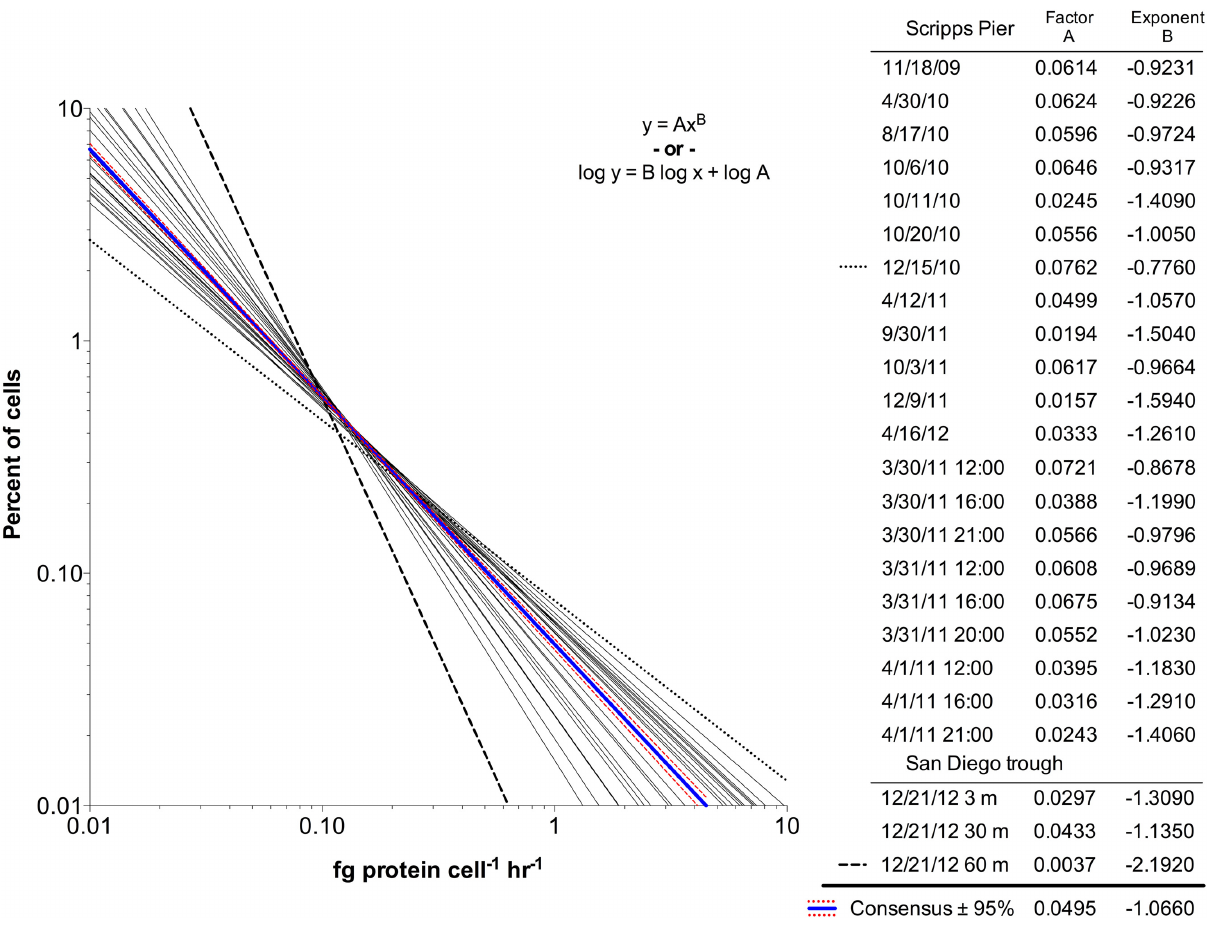
fits are shown (Factor A and Exponent B). A global fit to consensus data and 95% confidence intervals are shown in blue and red, respectively. The most divergent samples are shown by the dashed lines (15-Dec-2010;